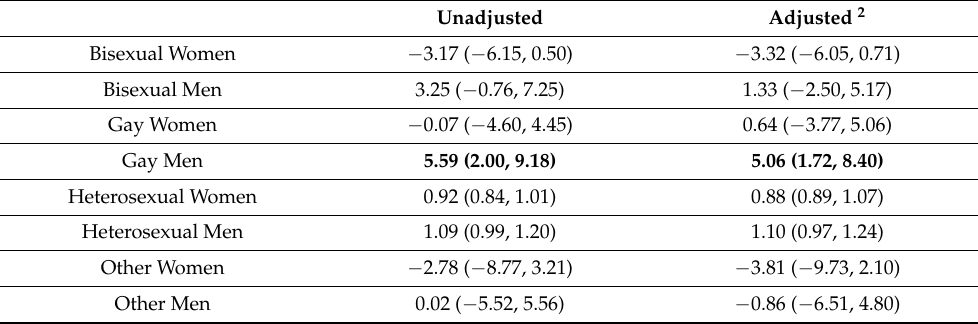
Table 3. Interrupted time series beta estimates 1 for trends before and after U.S. national marriage equality, associated with health care access and satisfaction scale, stratified by sexual identity and gender among sex and sexual identity ( n =